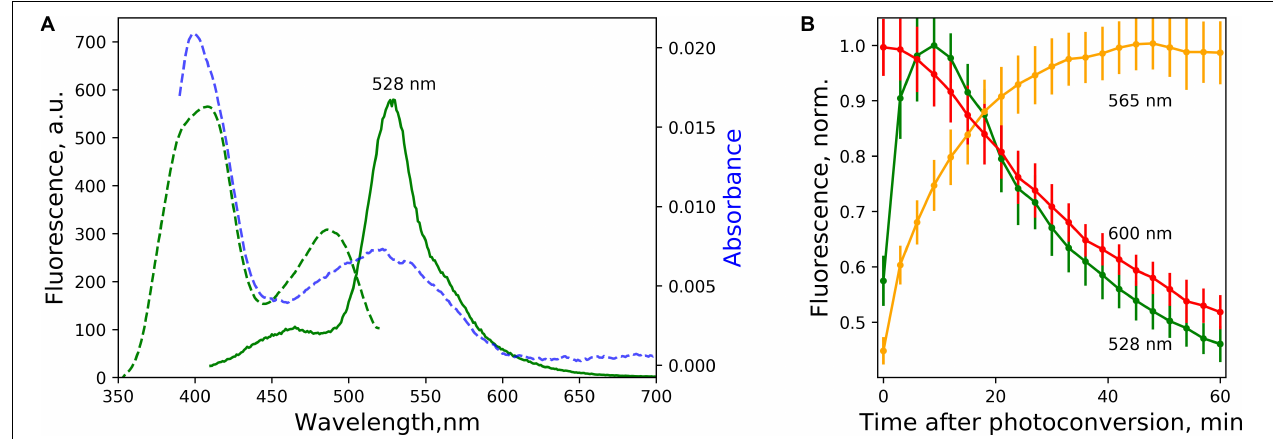
FIGURE 2 | Green-emitting forms and the time course of light-independent interconversion of spectral species. (A) Excitation (green dashed line, emission at 530 nm) and emission (green solid line, excitation at 400 nm) spectra of green-emitting form 5 min after photoconversion. Blue dashed line – absorbance after the photoconversion. (B) Time course of light-independent fluorescence change of the forms with emission at 525 nm (excited at 400 nm), 565 nm, and 600 nm (excited at 525 nm) after the photoconversion, pH = 7.4. The lines represent the mean value, error bars – standard deviation ( n = 3 independent photoconversions).